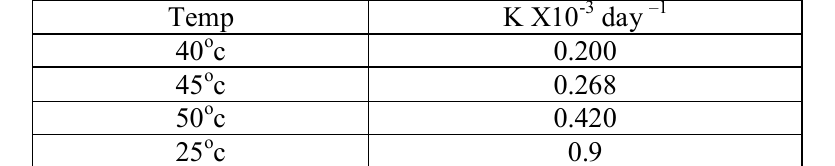
Table-4 Degradation Rate Constants (K) of Econazole Nitrate in Formula E at Different